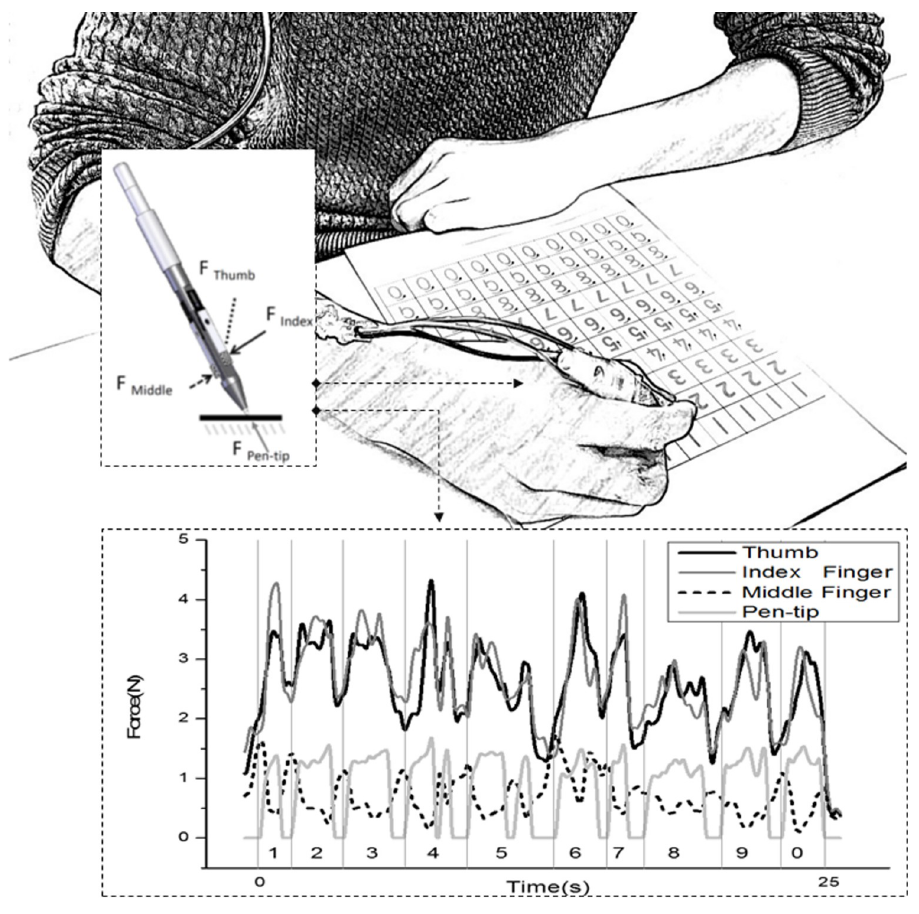
Fig 1. FAP system. Settings of the FAP system, pen design and force data obtained in one trial from the control group.